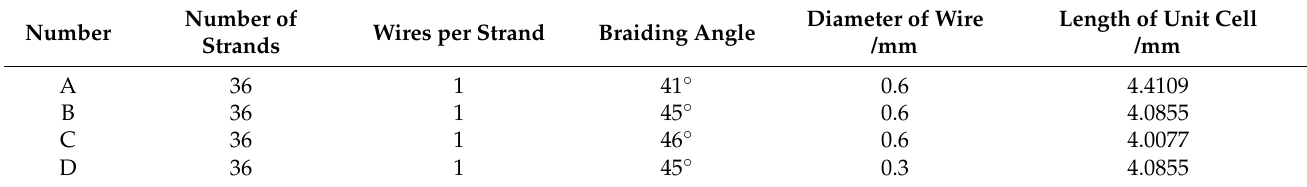
Table 2. Structural parameters of the metallic braided tube.